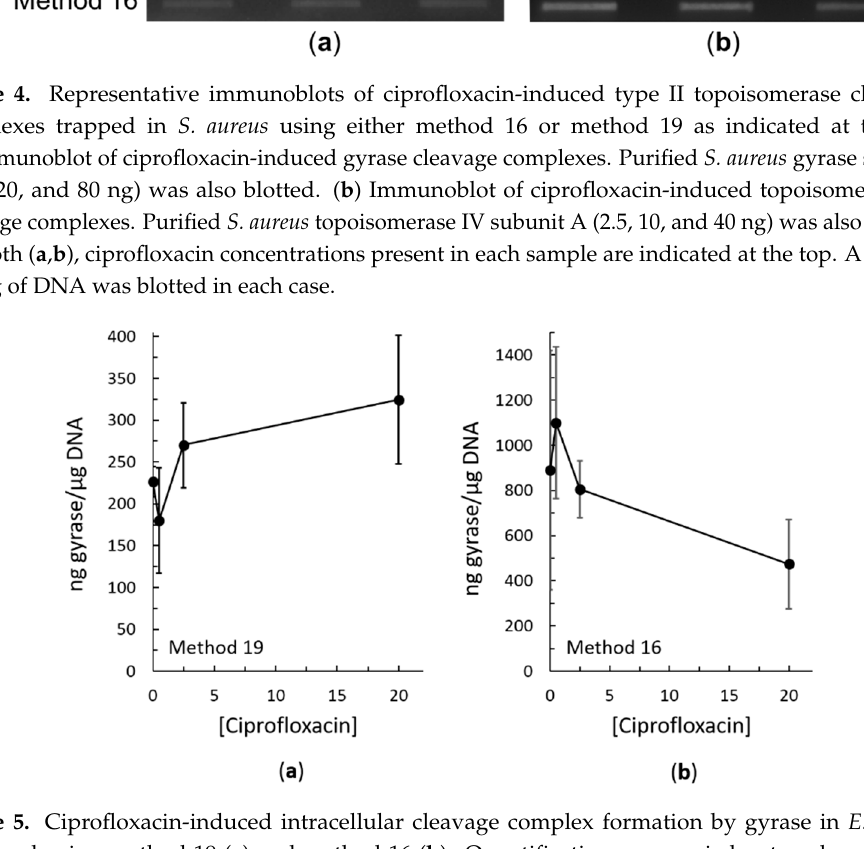
Figure 5. Ciprofloxacin-induced intracellular cleavage complex formation by gyrase in E. coli as measured using method 19 ( a ) and method 16 ( b ). Quantification was carried out as described in Figure 3 using a simultaneously blotted purified E. coli gyrase subunit A standard. In ( a ), error bars represent the standard error of the mean of two independent experiments. In ( b ), error bars represent the standard deviation of three independent experiments.